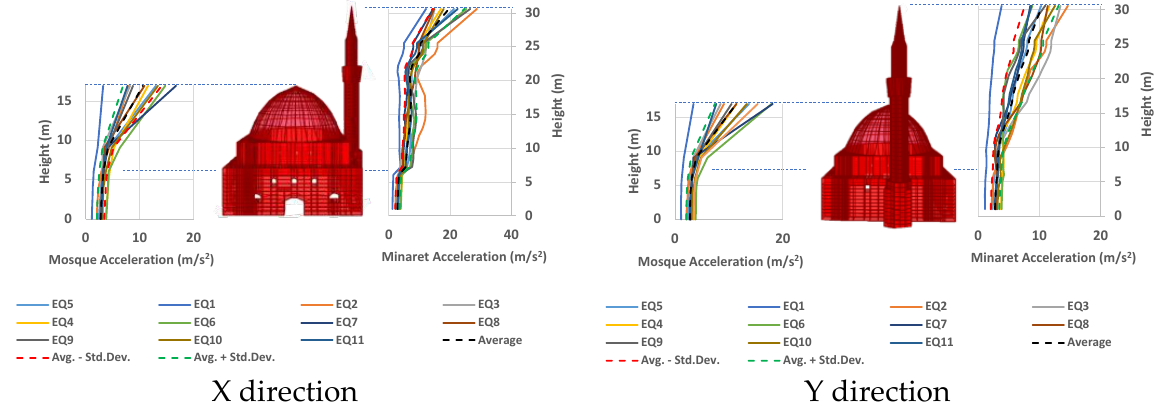
Figure 10. Mosque and minaret absolute acceleration for the fixed-base case.